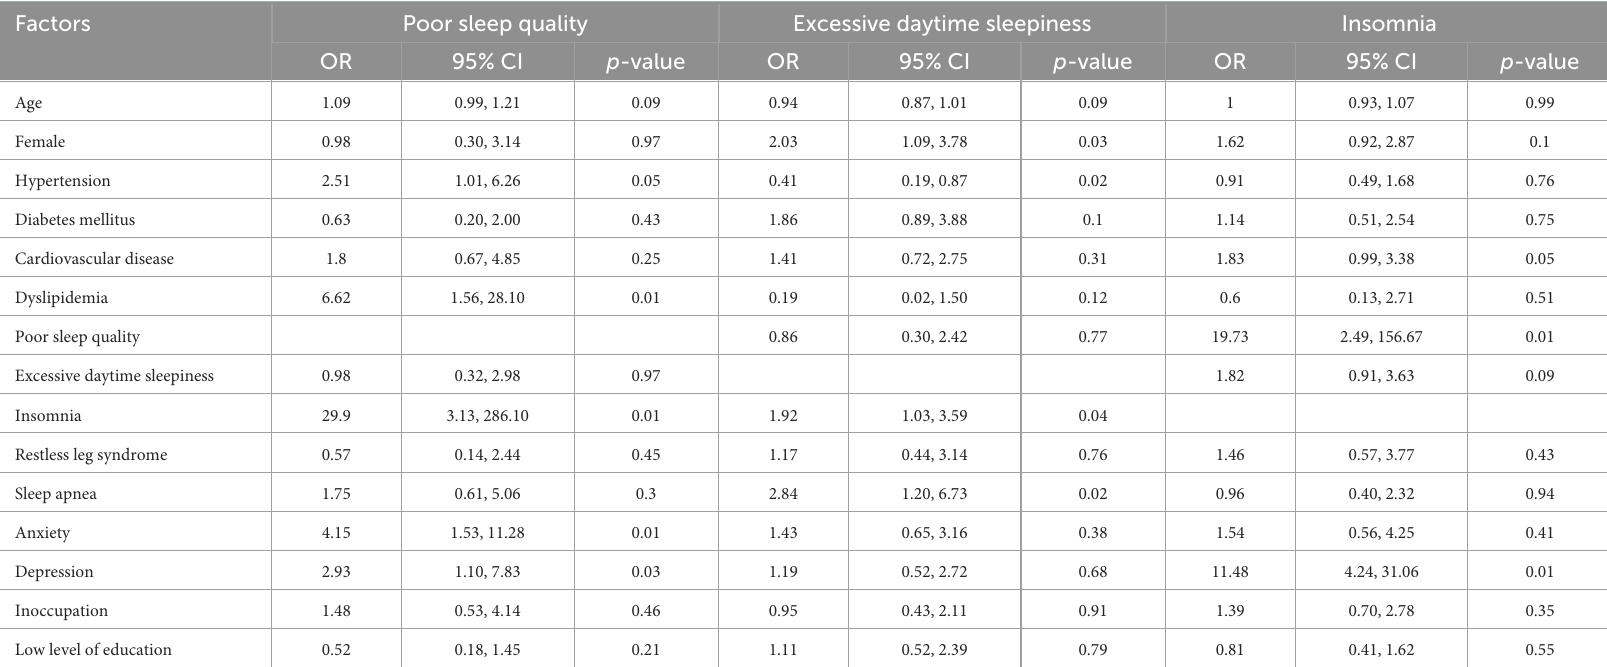
TABLE 5 Risk factors for poor sleep quality, excessive daytime sleepiness, and insomnia in the elderly population.